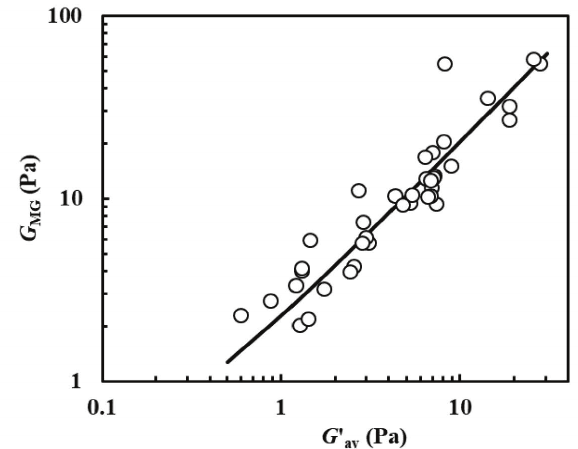
Fig. 3 – Dependence of the shear modulus evaluated accord- ing to the MG strategy (open circles, G value of the elastic modulus (G’ The solid line represents the linear interpolant evaluated ac- cording to a robust fitting approach.